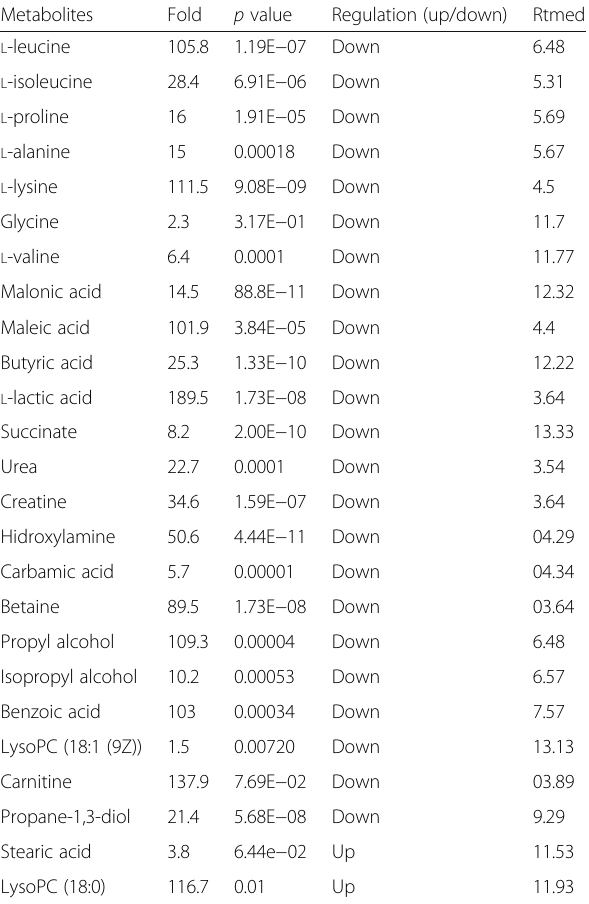
Table 2 Identified metabolites of metabolomics study in patients with NSTEMI compared to STEMI